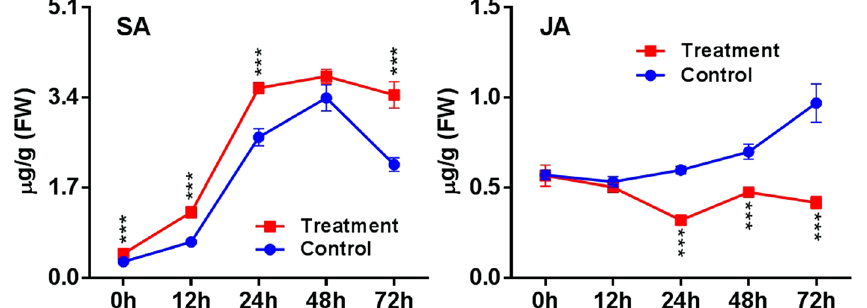
Figure 6. Salicylic acid (SA)- and jasmonic acid (JA)- contents after infection with B . cinerea in A . thaliana exposed to 1000 Hz sound vibration. Analysis of SA and JA contents was performed by liquid chromatography- mass spectrometry (LC-MS) and shown in a line graph, where red and blue colors indicate SV-treated and control plants respectively. Analysis was performed with three biological replications. P -value ranges are marked by asterisks: *** P < 0.01, ** 0.01 < P < 0.05, * P <